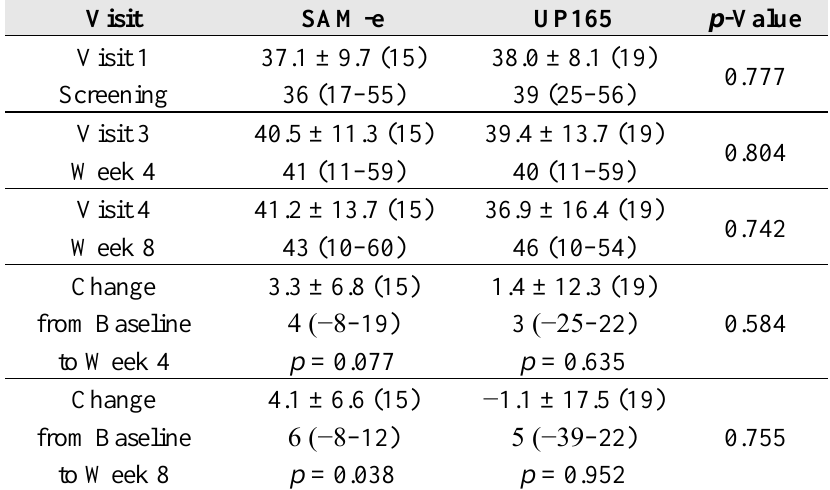
Table 4. SOS-10: Schwartz Outcome